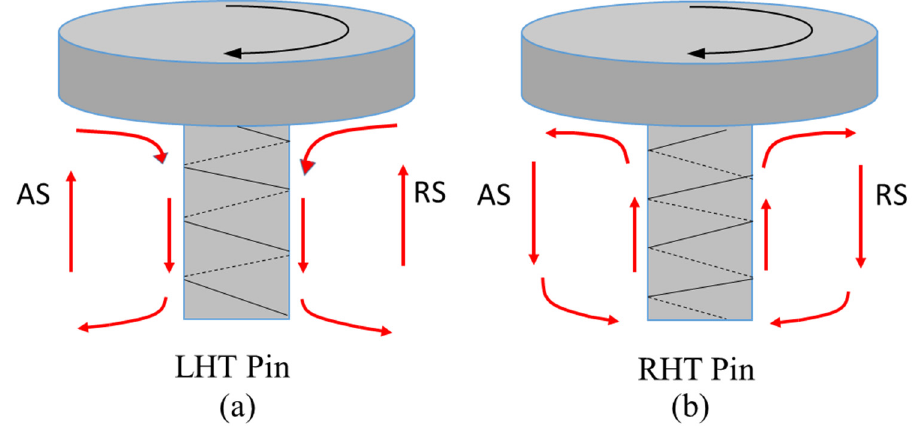
Figure 6. Material flow pattern during friction stir welding/processing (FSW/P) showing ( a ) ring vortex, ( b ) rigid disc rotational, and ( c ) uniform translational flow fields.